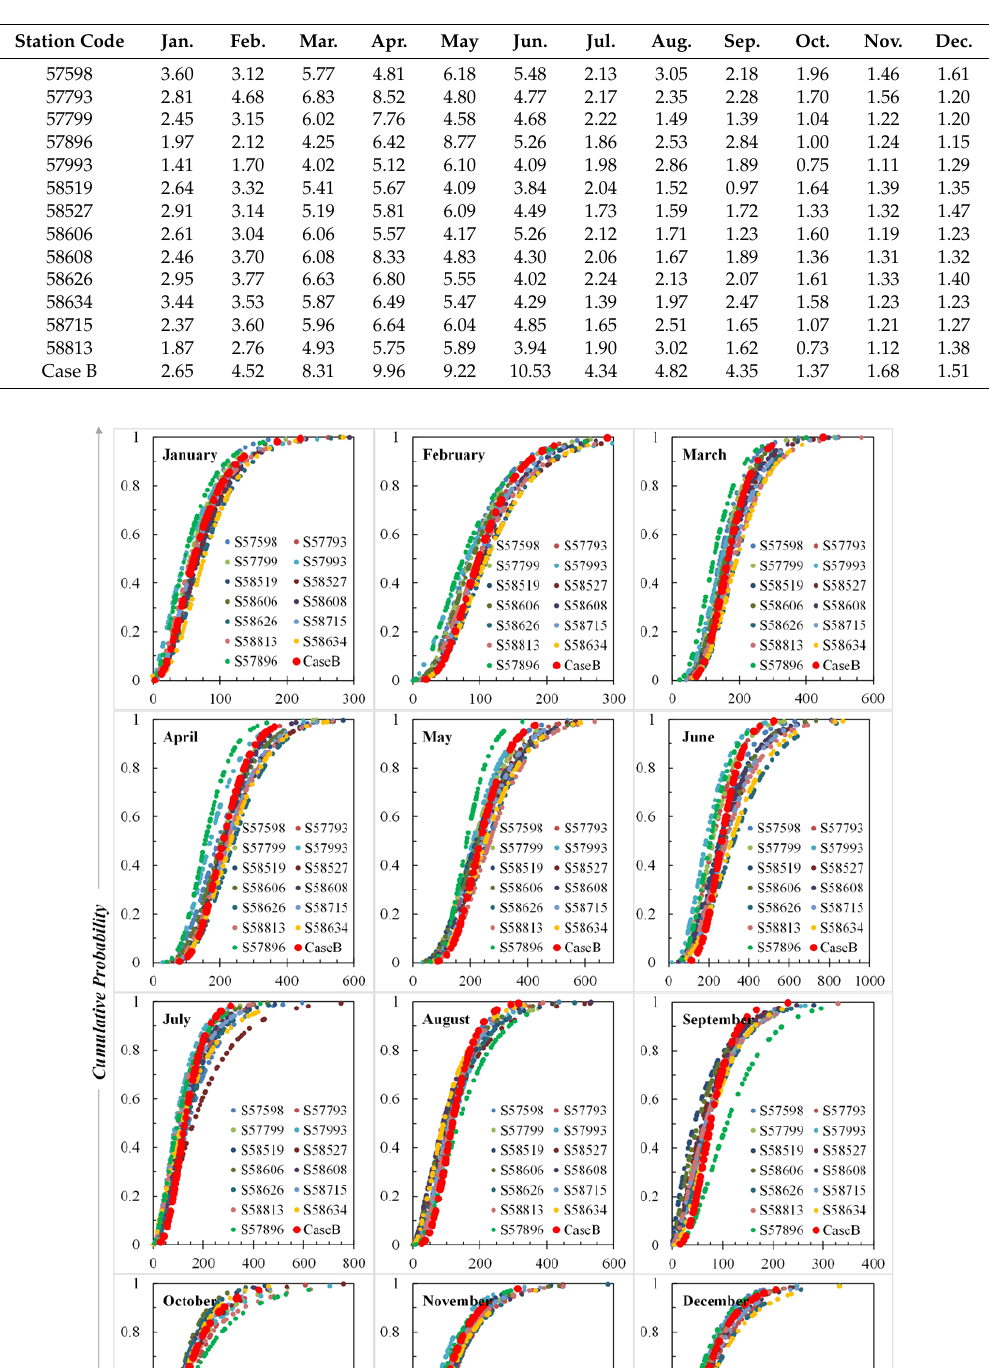
Table 3. Shape parameters of Gamma distribution for 13 stations and that for precipitation-average scheme from January to December.